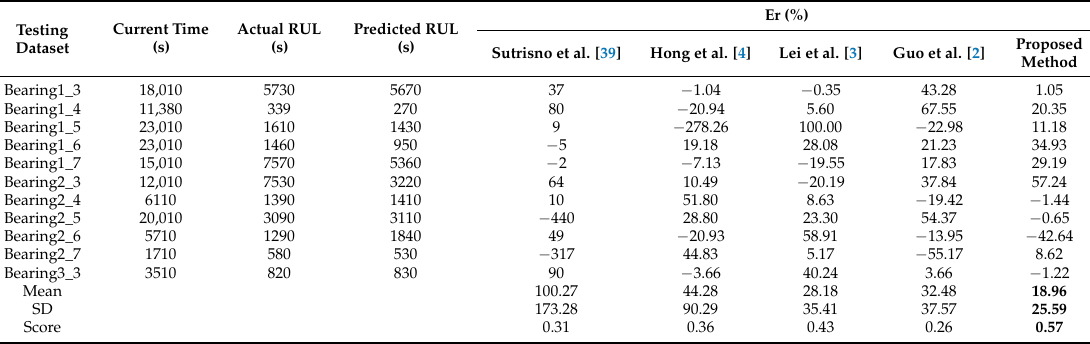
Table 2. Performance comparisons of the proposed method with related research on the PRONOSTIA